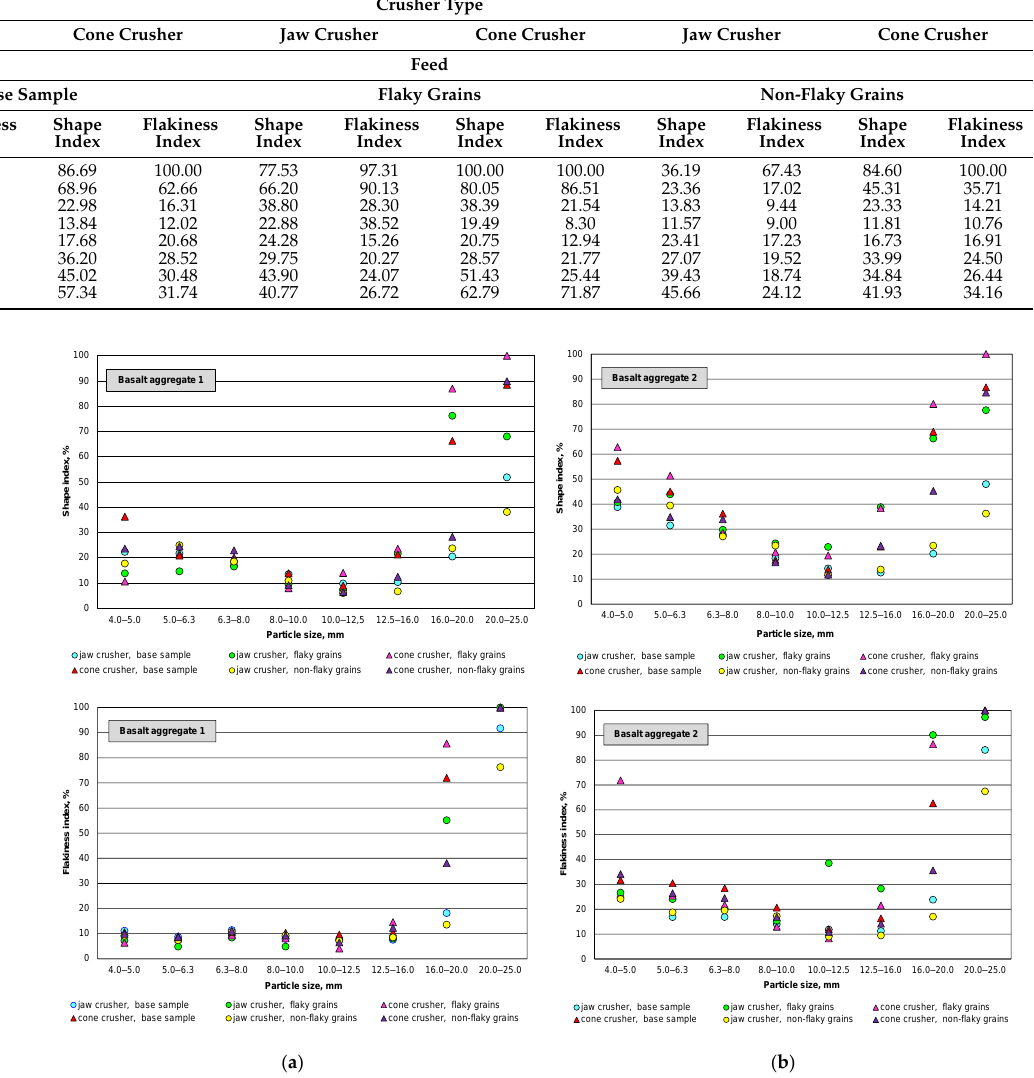
Figure 6. Comparison of geometric indexes for analyzed basalt aggregates: ( a ) basalt 1; ( b ) basalt 2. Figure 7 shows the geometrical characteristics of the basalt aggregates after jaw and cone crushing. The graph was presented based on a three-parameter system, determining the distribution of shape and flakiness indexes for each grain class. This allowed a three- parameter analysis of the distribution of geometric properties of the products obtained after crushing. The colors on the graph mark the type of feed and the type of crusher used for crushing, while the shape of the marker indicates the deposit from which the material comes. Based on the analysis of the three-dimensional distribution of the geometrical prop- erties of the analyzed aggregates (Figure 7), it can be concluded that basalt 2 had a higher content of flaky and non-cubical grains, especially in the fine grain class system. The basalt aggregate with a low degree of weathering and low tuff content is generally crushed in the form of non-flaky cubical grains. Aggregates with lower strength parameters, as in the case of the aggregates studied — basalts with a higher content of grains other than pure basalt, show worse geometrical parameters after crushing, as confirmed by Gawenda et al. [49].